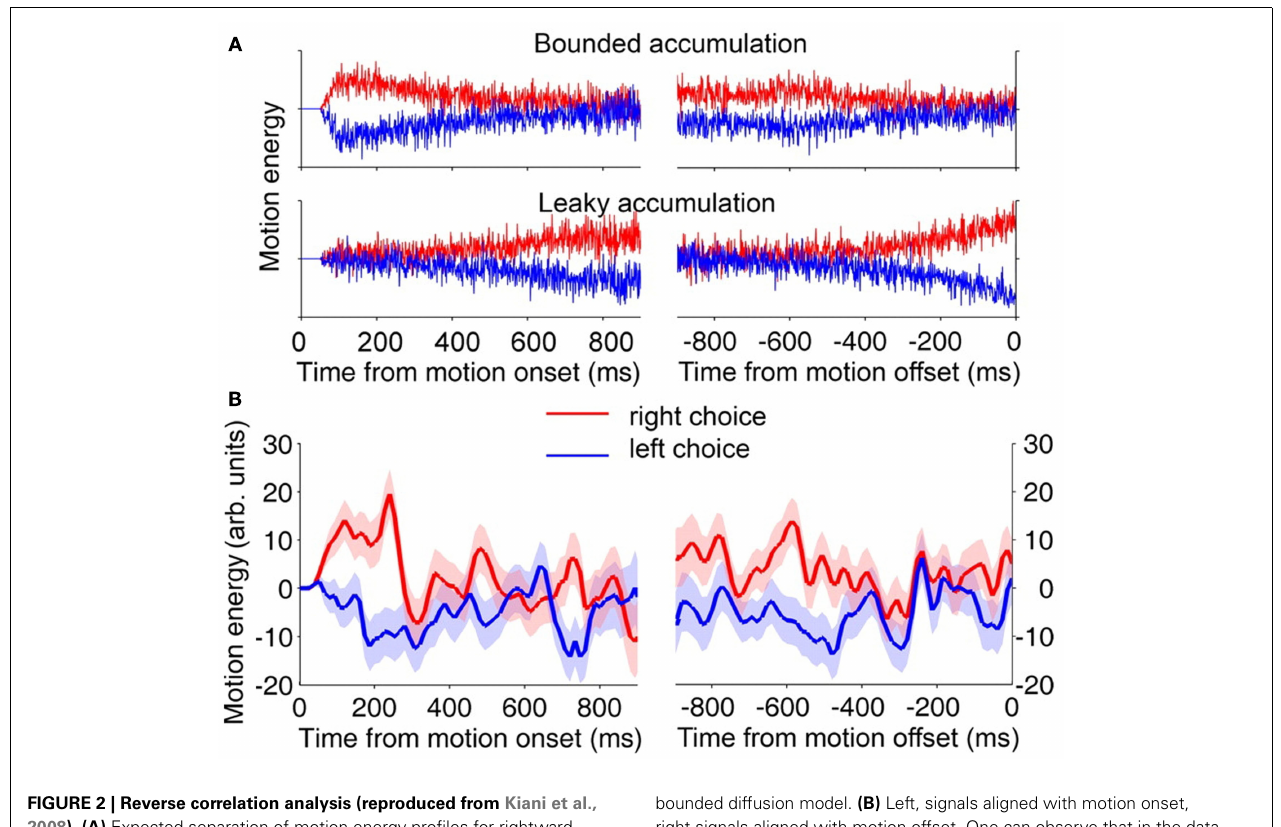
FIGURE 2 | Reverse correlation analysis (reproduced from Kiani et al., 2008). (A) Expected separation of motion energy profiles for rightward (red) and leftward (blue) choices for bounded diffusion (top) and leak-dominant LCA (bottom). Late information is more critical in the leak-dominant LCA model while early information is more critical in the